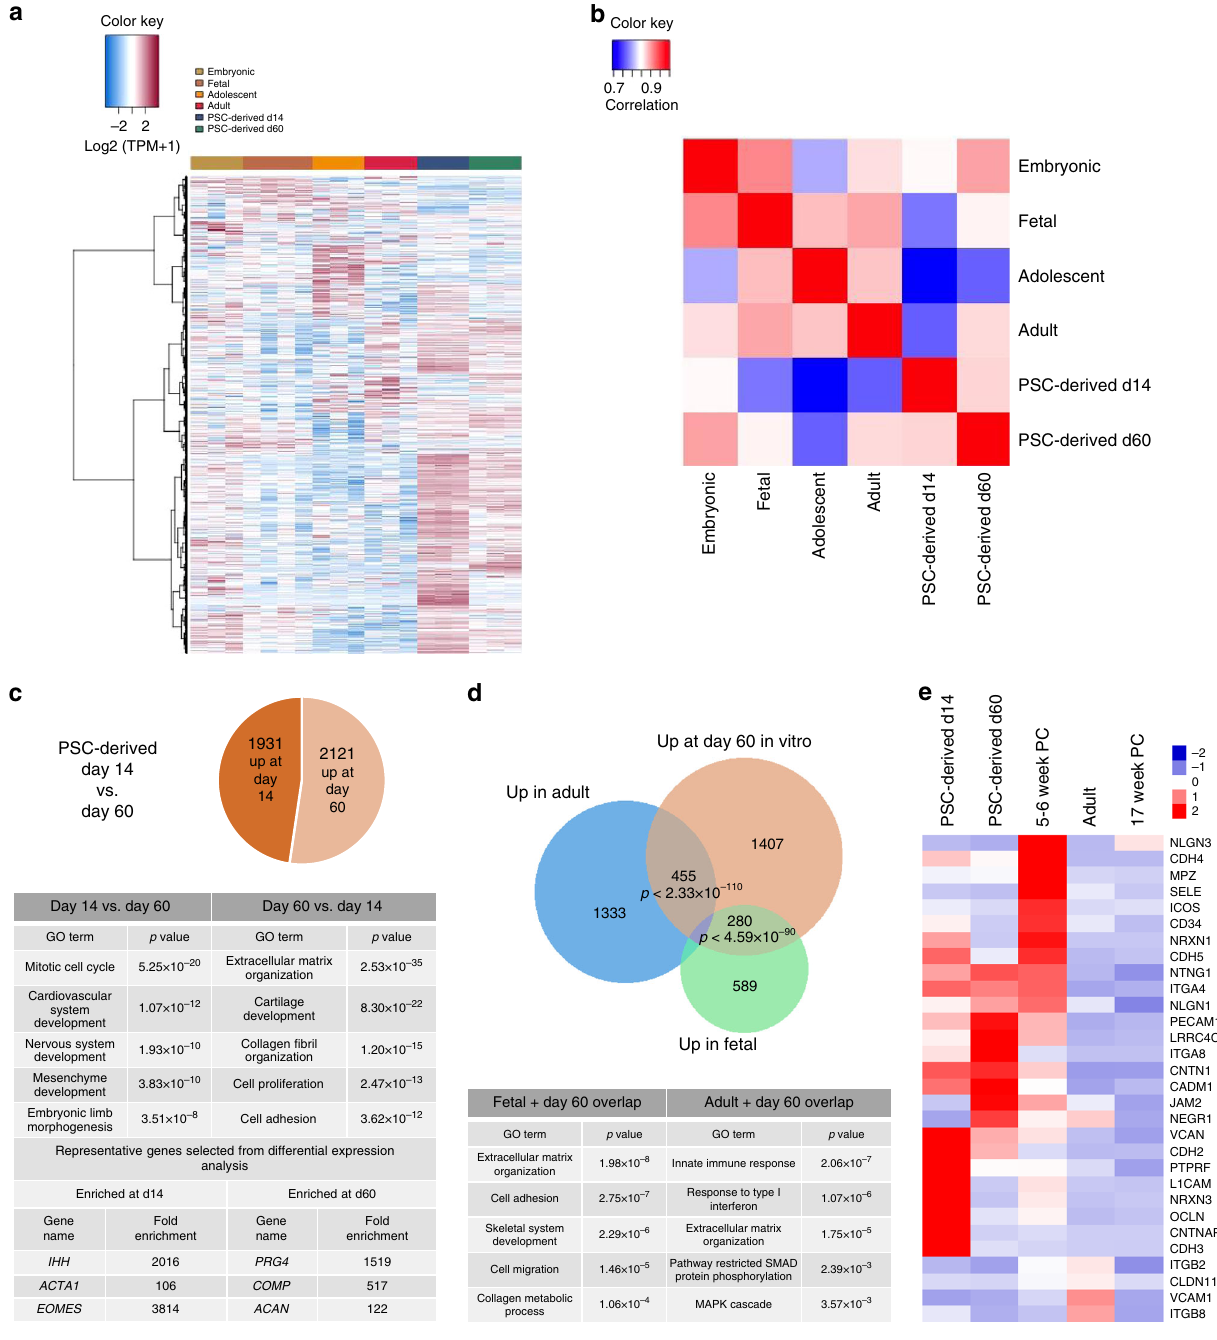
Fig. 4 Transcriptional comparison of PSC-derived chondrocytes and in vivo human cartilage development a Hierarchical clustering of 15,000 genes expressed across all 4 stages of human ontogeny and 2 stages of PSC-derived chondrocytes. b Spearman correlation matrix of the relatedness of the samples. c Selected GO terms and genes enriched between d14 (left) and d60 (right) pluripotent stem cell-derived chondrocytes. d Genes enriched in d60 PSC-derived chondrocytes signi fi cantly overlap with those enriched in adult (adult vs. fetal) and fetal (fetal vs. embryonic) cells. Selected GO terms from these overlaps are shown. e Relative gene expression values at different stages of chondrogenesis and PSC-derived cartilage of cell adhesion molecules (CAMs) enriched in d14 vs. d60 chondrocytes. N = 3 –